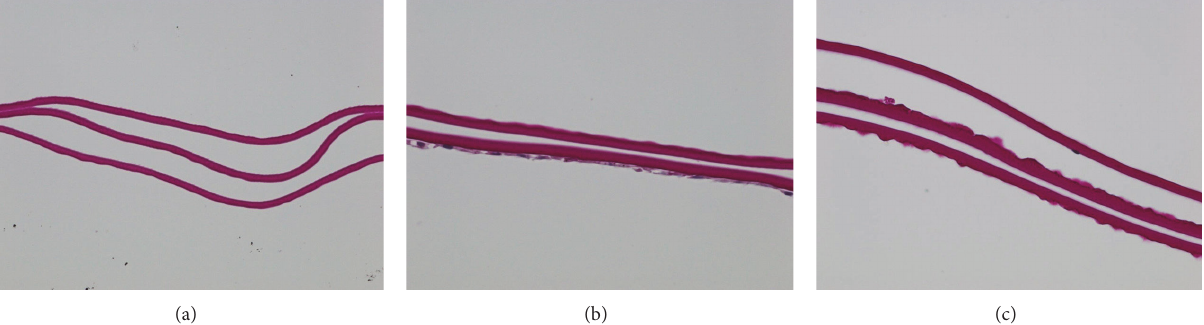
Figure 2: Histological analysis on preloaded DMEK lenticules after preservation at 100x magnification. (a) C1 showed no presence of endothelium due to major cell fall-off, (b) C2 showed presence of endothelium and DM without any stromal remnants, and (c) C3 showed limited endothelium.